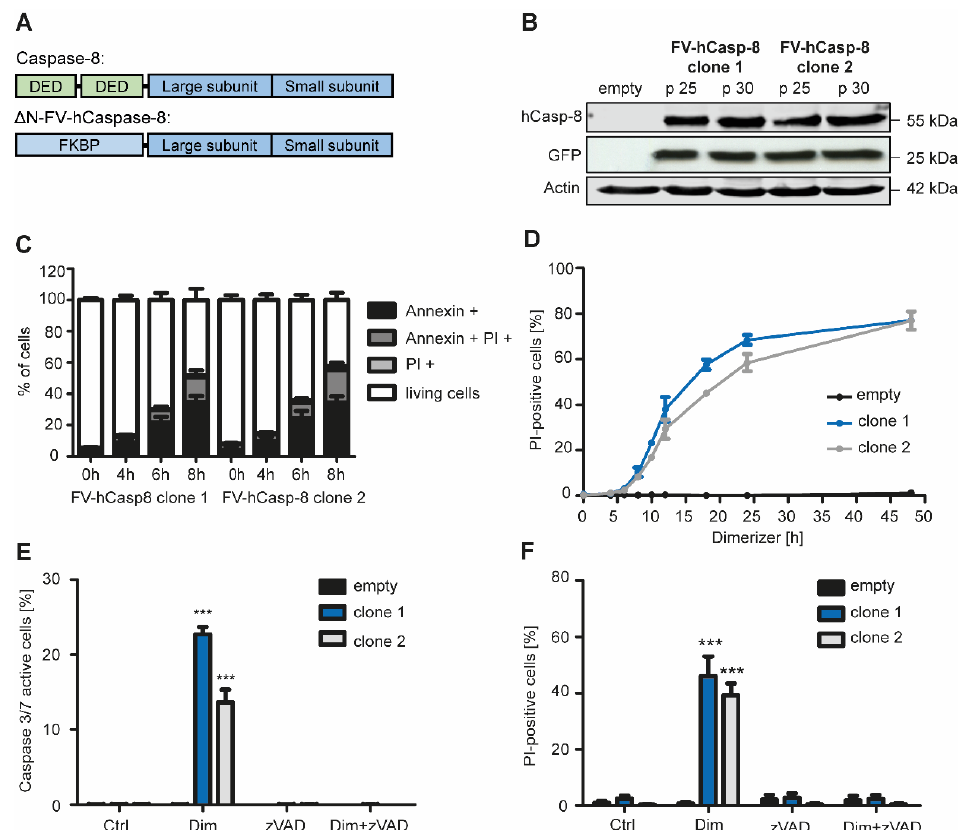
Figure 1. Generation and validation of an inducible cell death system of apoptosis. ( A ) DED domains of human caspase-8 were replaced by the dimerizer domain FKPB. Addition of dimerizer to NIH 3T3 cells expressing FV-hCaspase-8 leads to dimerization of caspase-8 and induction of apoptosis. ( B ) Two different single clones of NIH 3T3 cells expressing FV-hCaspase-8 were selected and protein expression of Caspase-8, GFP and Actin were analyzed by Western Blotting after 25 or 30 passages (p). ( C ) Annexin V and PI positive cells were analyzed over time using flow cytometry after treatment with 10 nM dimerizer ( n = 4). ( D ) 10 nM dimerizer were added to NIH 3T3 cells and cell death was observed over time by counting PI-positive cells ( n = 3). ( E ) Active Caspase 3 or 7 positive cells were counted 10 h after treatment with dimerizer and/or zVAD.FMK ( n = 3). ( F ) The pan-caspase inhibitor zVAD.FMK was added and cells were treated for 18 h. PI-positive cells were counted ( n = 3). Mean ± SEM are shown, *** p <